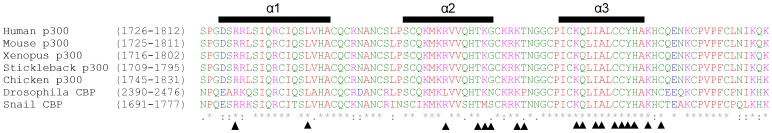
Multiple sequence alignment of the highly homologous TAZ2 domains of p300 and CBP.The multiple sequence alignment of the TAZ2 domain of human, mouse, western clawed frog (Xenopus tropicalis), stickleback and chicken p300, and drosophila and pond snail CBP, illustrates the high degree of sequence homology between the TAZ2 domains of a diverse range of species. Residues are coloured according to the residue type, with small and hydrophobic residues in red (AVFPMILW), acidic residues in blue (DE), basic residues in magenta (RK) and residues containing a hydroxyl, sulfhydryl or sidechain amide group in green (STYHCNQ). Glycine was also coloured in green. Consensus symbols are shown below the sequence. Residues marked with an ‘*’ were fully conserved between sequences. The symbol ‘:’ indicates conservation between groups with strongly similar properties and ‘.’ indicates conservation between groups of weakly similar properties. TAZ2 residues that were significantly shifted upon binding to B-Myb are indicated by triangles shown below the consensus. The positions of the helices in p300 TAZ2, which were identified by analysis of the backbone resonance assignments using the chemical shift index method are indicated above the sequence. The alignment was prepared using ClustalW.